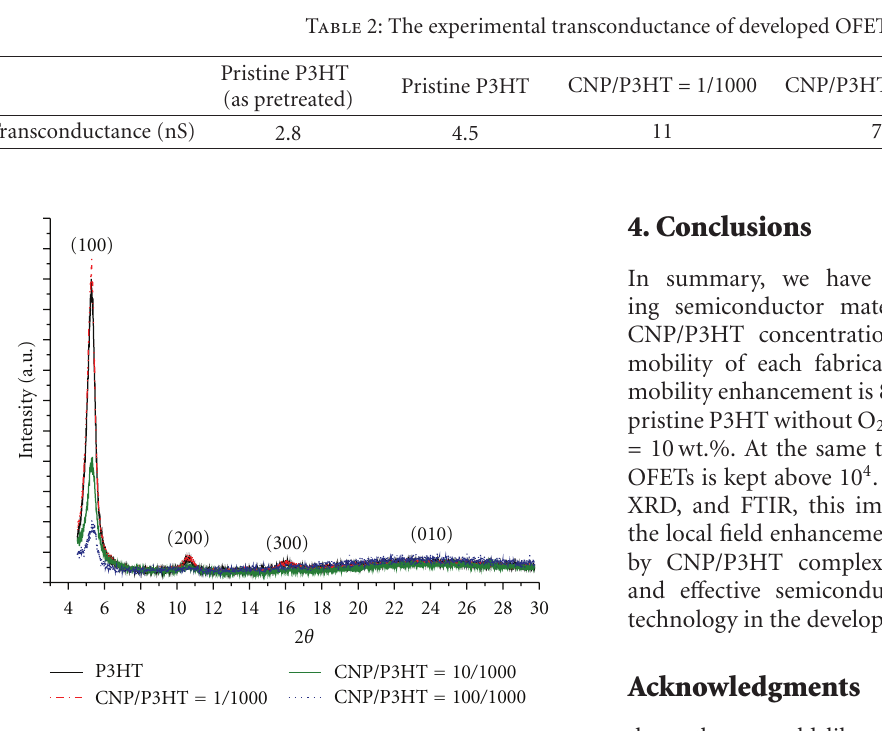
Figure 5: XRD image of pristine CNP/P3HT and di ff erent CNP concentrations.